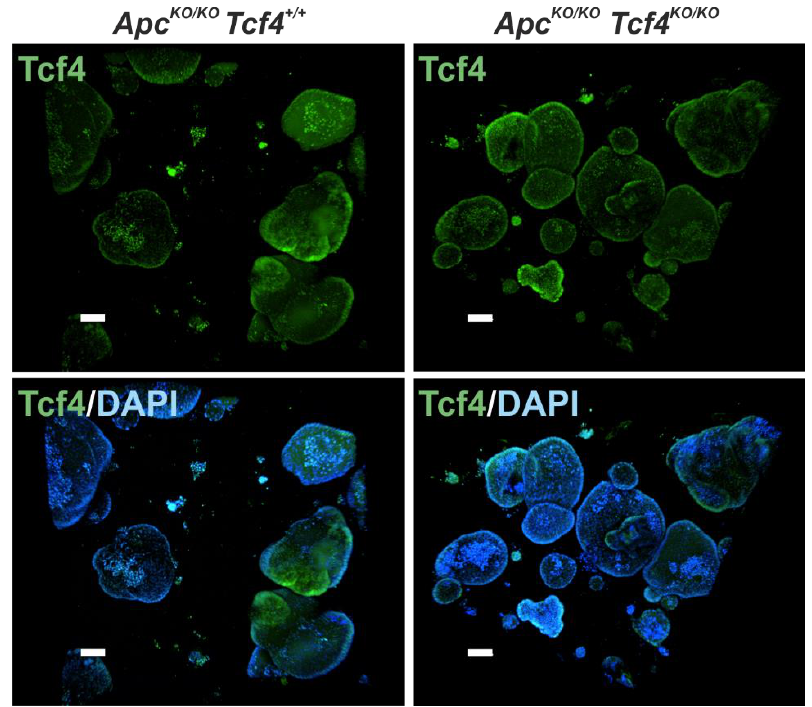
Figure 8. Small intestinal organoids derived from the transformed epithelium produce Tcf4. Fluorescent microscopy images of tumor organoids (spheroids) derived from the small intestine of Apc flox14/flox14 Tcf4 +/+ Lgr5-CreERT2 ( Apc KO/KO Tcf4 +/+ ) and Apc flox14/flox14 Tcf4 flox5/flox5 Lgr5-CreERT2 ( Apc KO/KO Tcf4 KO/KO ) mice 28 days after tamoxifen administration. Samples were stained using an anti-TCF4 antibody (green fluorescence) and they were counterstained using diamidino-2-phenylindole (DAPI) stain (blue nuclear fluorescence). Scale bar: 100 μm.